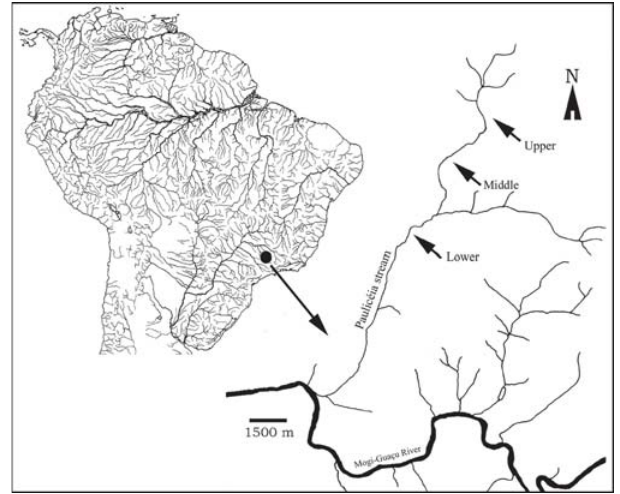
Fig. 1. Location of the study area in the Paulicéia stream,